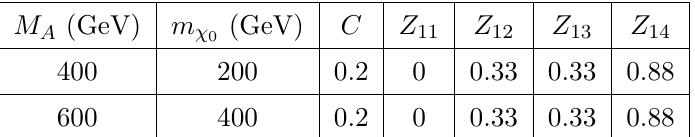
Table 2 . Benchmark points used to (cid:12)nd out the relic density and SI direct detection cross section of pNGB DM using pNGB-LSP interaction. We mention physical masses of neutralino ( (cid:31) 0 ) and pseudoscalar Higgs A and mixing pattern of neutralinos. All masses are in